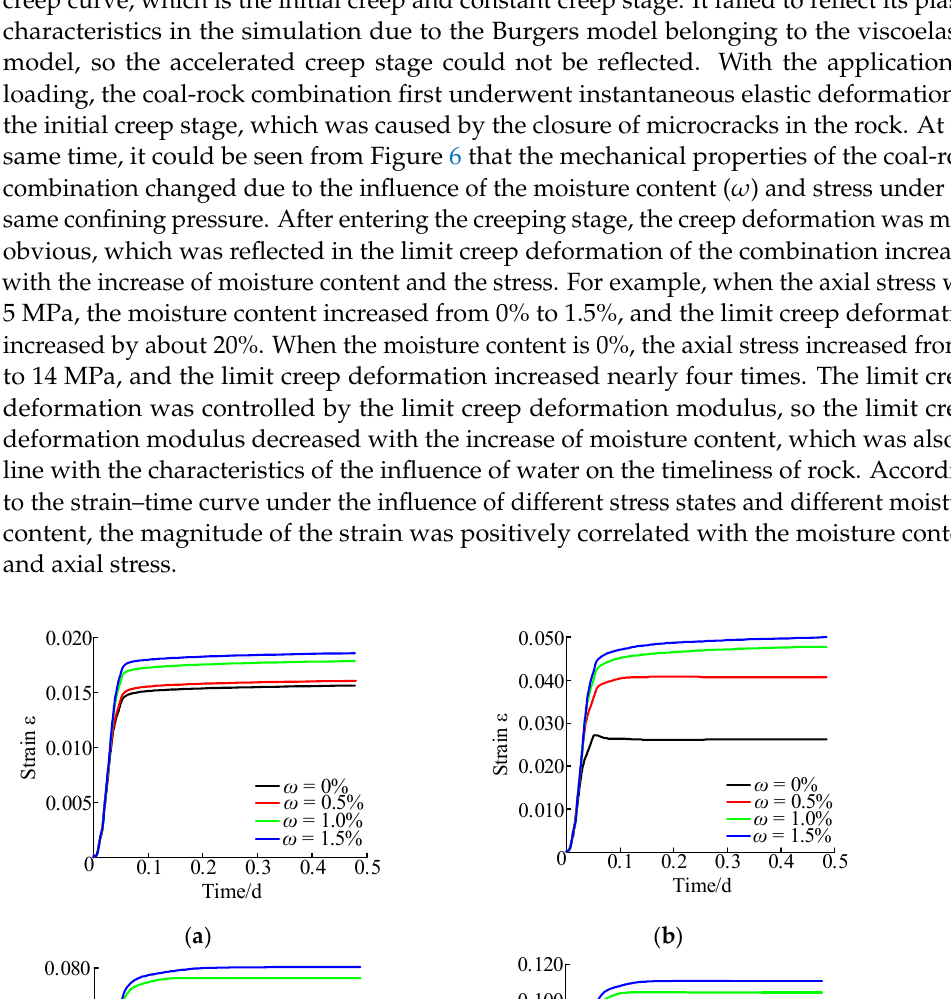
Figure 7. Instantaneous elastic deformation stage when the axial stress is 5 MPa. 3.2.2. Strain Rate Characteristics The important indicator to show the creep speed of the coal-rock combination was strain rate. The different moisture contents had an important influence on the strain rate. The greater the moisture content of the coal-rock combination was, the greater the strain rate was. It would eventually become stable, which is entering the constant creep stage. At this time the strain rate was approximately a constant value. Strictly speaking, the